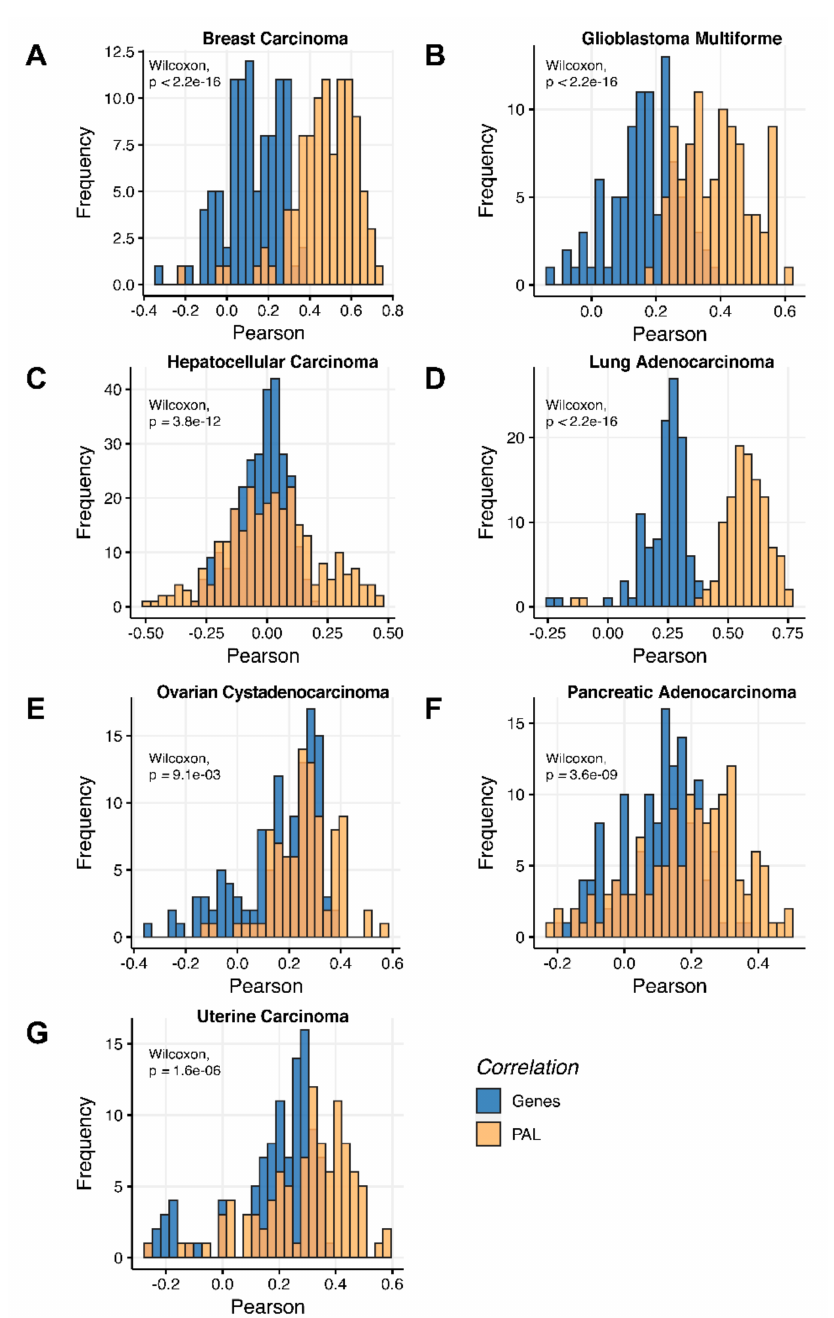
Figure 17. Gene-to-gene and PAL-to-PAL Pearson correlation between RNA and protein expression levels estimated by individual samples across ( A ) Breast Invasive Carcinoma, ( B ) Glioblastoma Multiforme, ( C ) Hepatocellular Carcinoma, ( D ) Lung Adenocarcinoma, ( E ) Ovarian Serous Cystade- nocarcinoma, ( F ) Pancreatic Ductal Adenocarcinoma and ( G ) Uterine Corpus Endometrial Carcinoma. Pearson and Spearman correlations for individual genes or molecular pathways were statistically significantly higher for pathway activation levels (Wilcoxon, both p < 2.2 × 10 − 16 , Figures 12A and